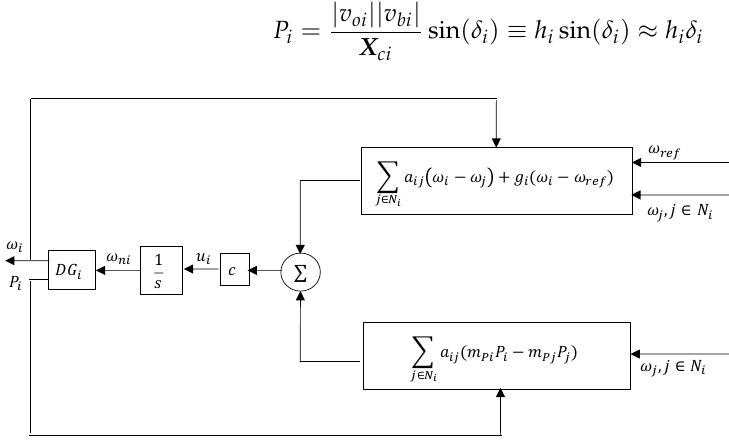
Figure 9. Distributed secondary frequency controller [112].